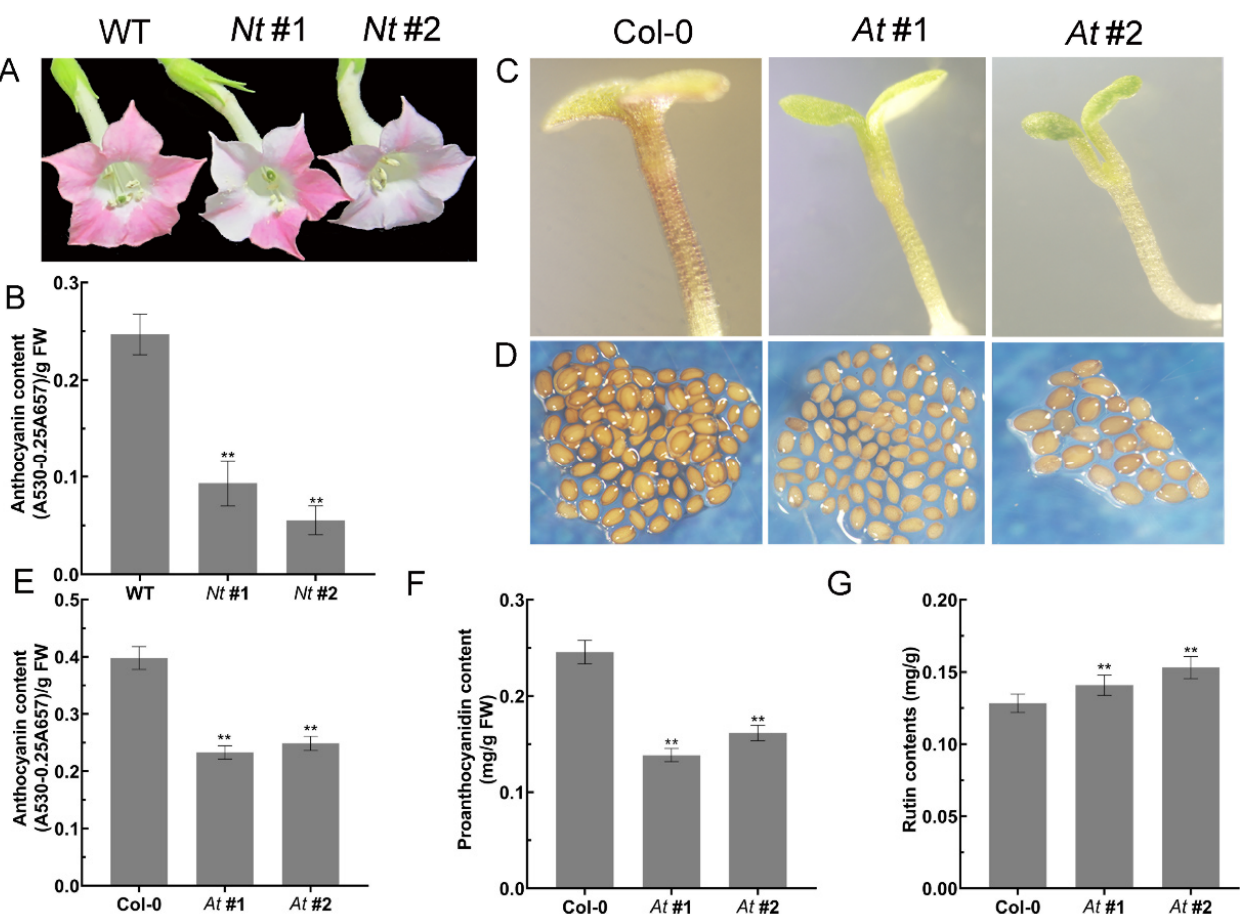
Figure 4. Phenotype of transgenic tobacco (termed Nt #1, Nt #2) and Arabidopsis (named At #1, At #2) overexpressing FtMYB3 . ( A , B ) Floral phenotypes and total anthocyanin of WT and two transgenic Nt #1 and Nt #2 at the flowering stage; ( C ) Pigmentation of 6-day-old seedlings in Arabidopsis WT (termed Col-0) and transgenic lines At #1 and At #2 after 24 h treatment under 4 ◦ C; ( D ) Colour of seed coats in the same Arabidopsis as above without treatments; ( E – G ) Anthocyanin, PA and rutin content in the same Arabidopsis at the flowering phase. Error bars represent ± SDs. ** means extremely significant difference at p < 0.01 level.